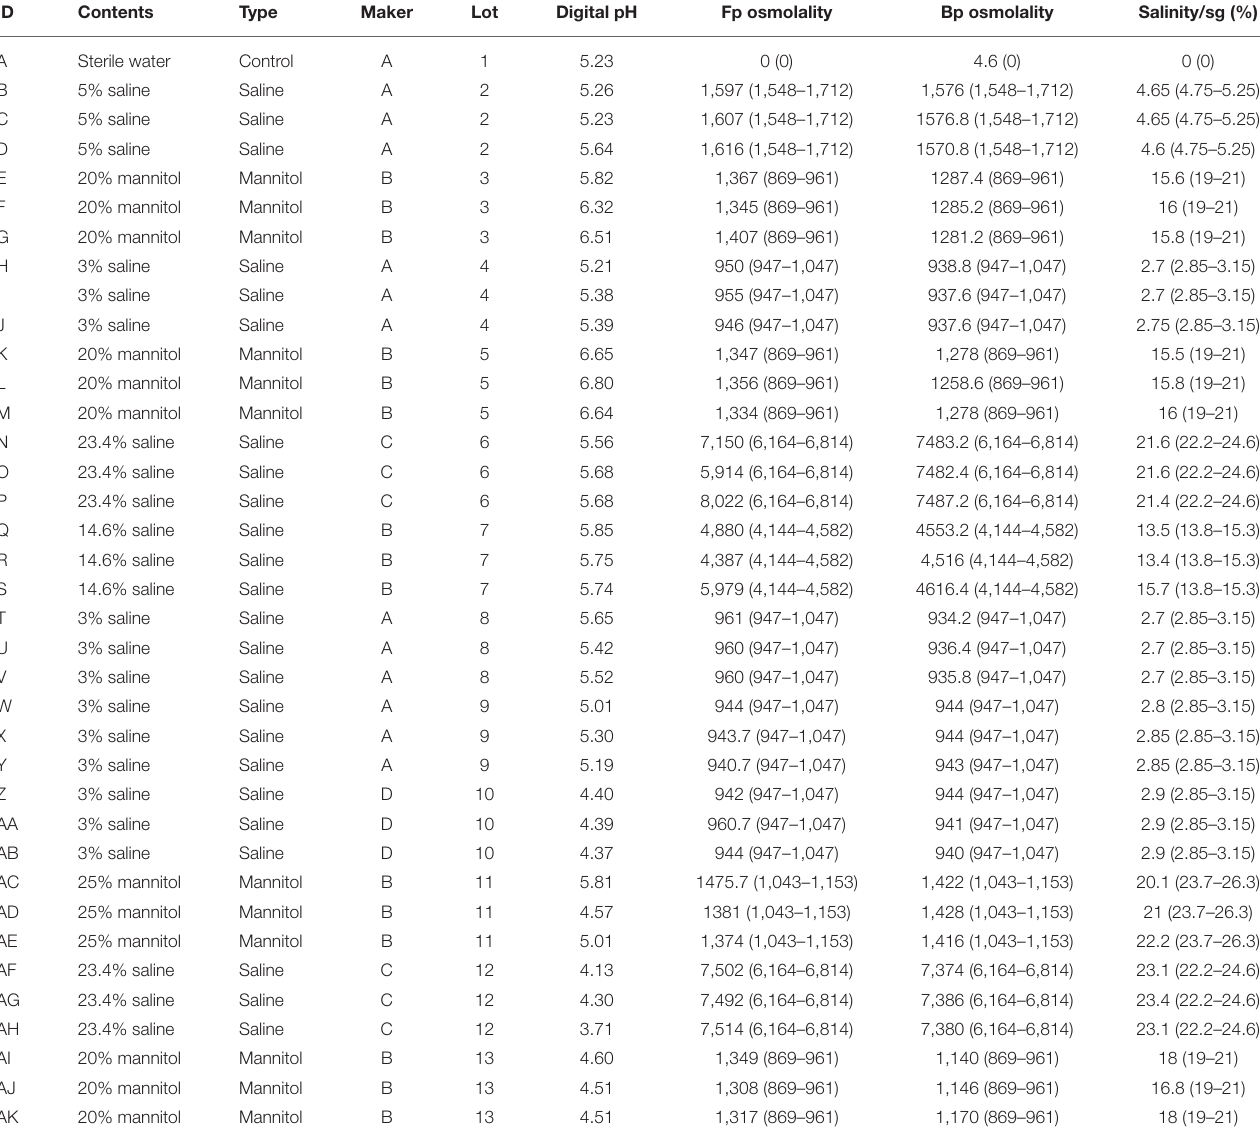
TABLE 1 | Measured solution physical